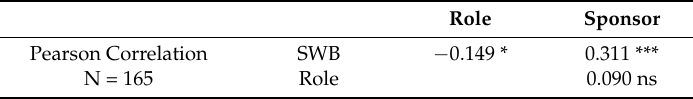
Table 8. Correlations and hierarchical regression analysis for teachers’